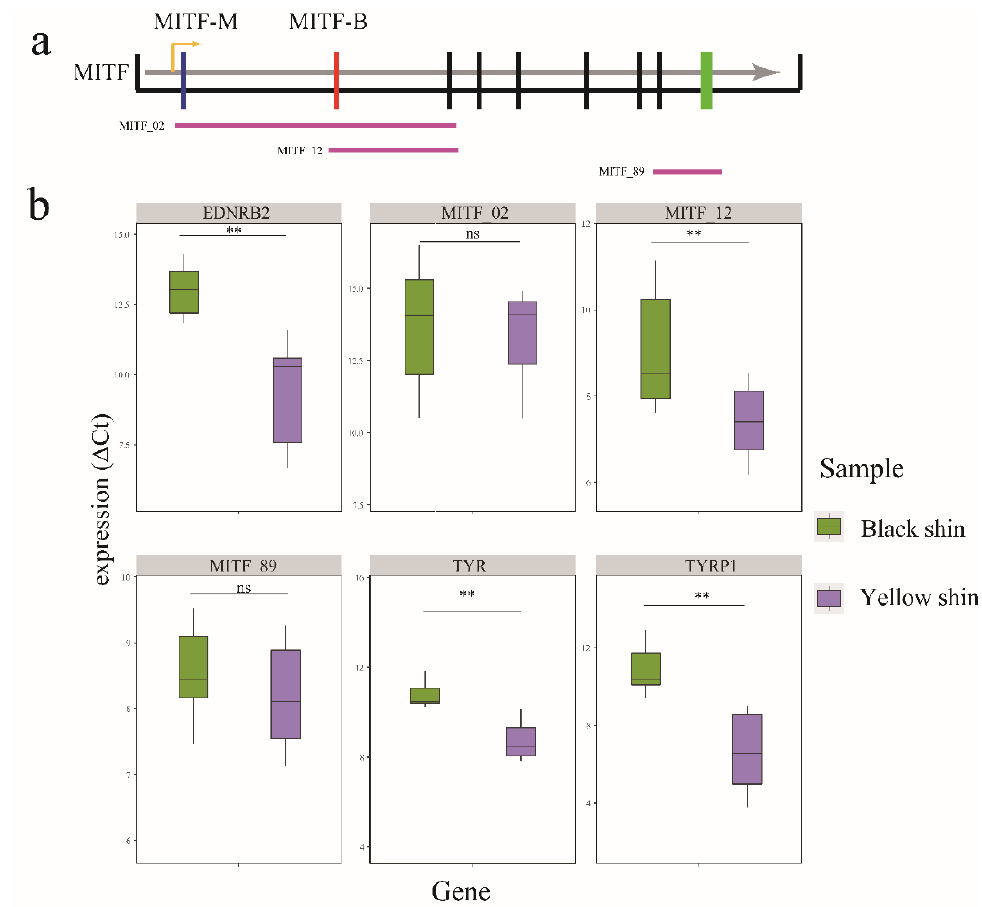
Figure 7. Expression differences of EDNRB2, TYR, TYRP1, and MITF in three exon junctions between black and yellow shins according to RT-qPCR. ( a ) MITF isoform. Exon 1M is specific for the MITF-M transcript, while exon 1B is specific for the MITF-B transcript; ( b ) EDNRB2, TYR, TYRP1, and MITF in three exon junctions between black and yellow shins. ** represents p value ≤ 0.01.